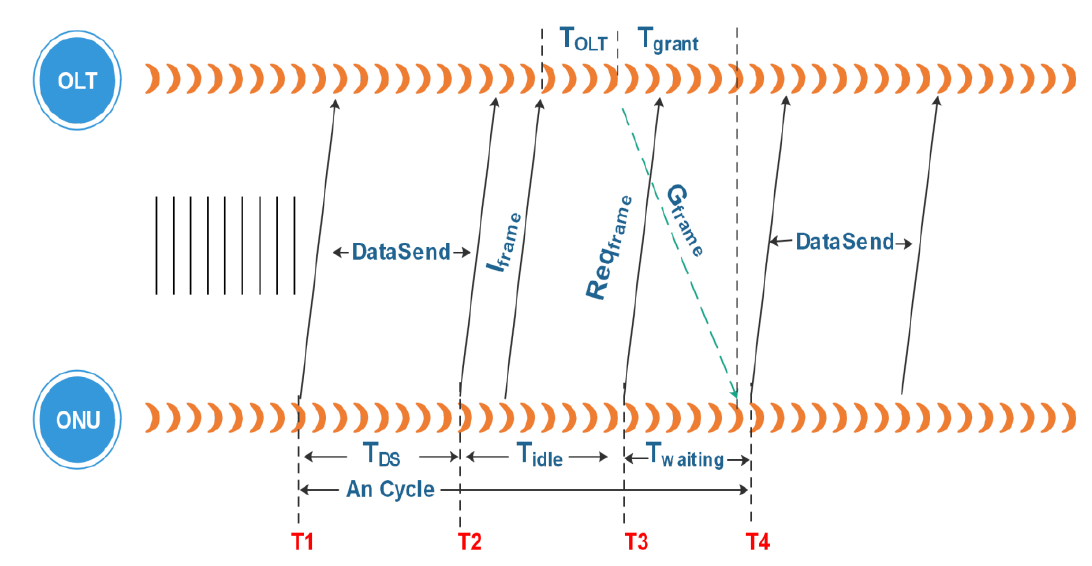
Figure 4. Demand Forecasting (DF)-DBA process diagram.